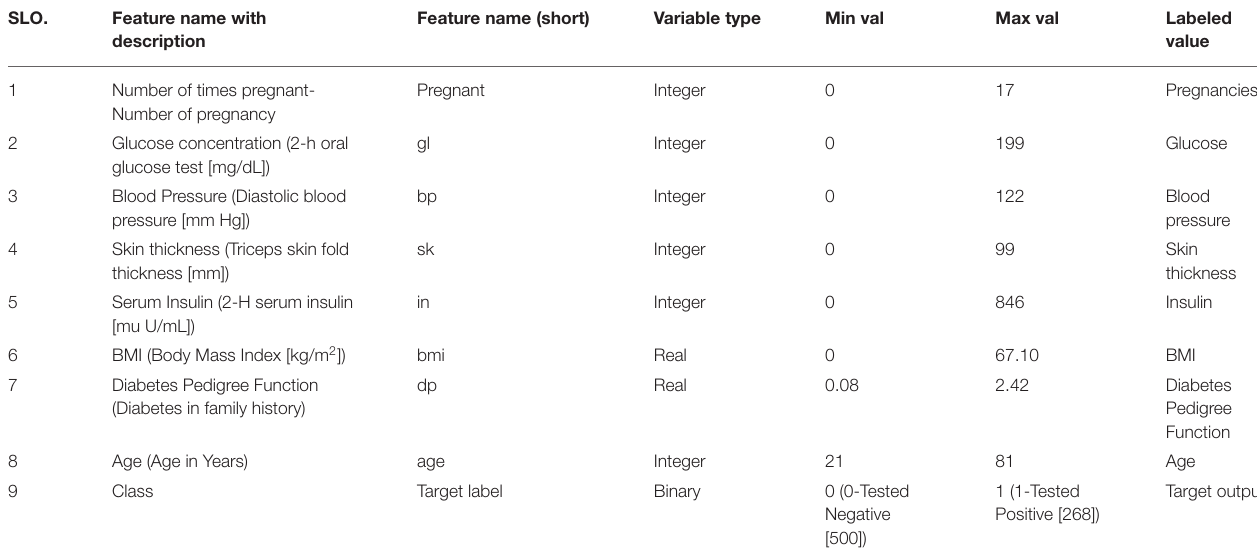
TABLE 4 | Attribute details of Pima Indian Diabetes dataset (PIDD). SLO.